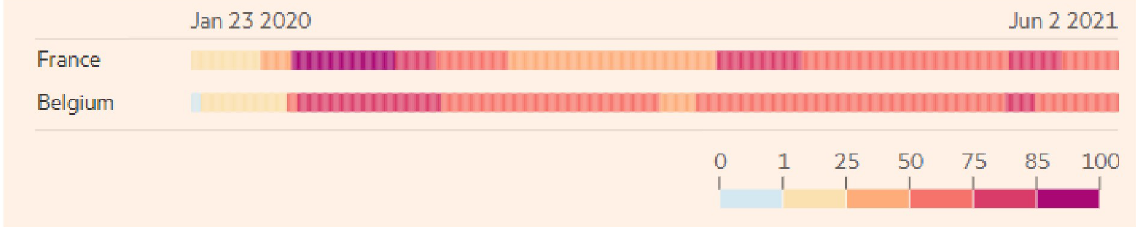
Fig 3. COVID-19 government response stringency on lockdown in Belgium and